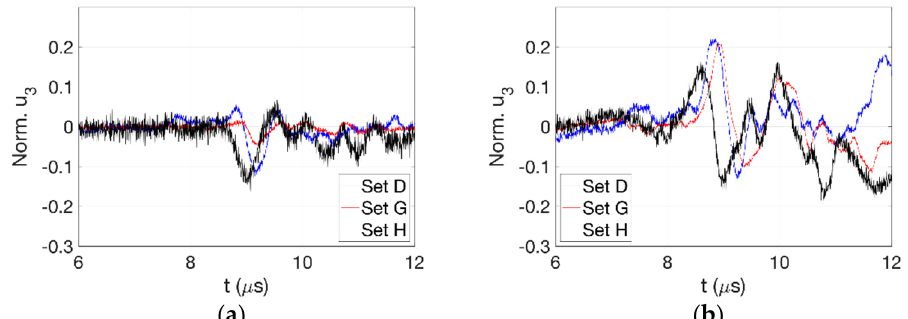
Figure 14. IN-718, 28 mm propagation distance, process parameter sets D, G, H where hatch spacing changes given laser pulse energies of ( a ) 30 mJ, ( b ) 120 mJ.